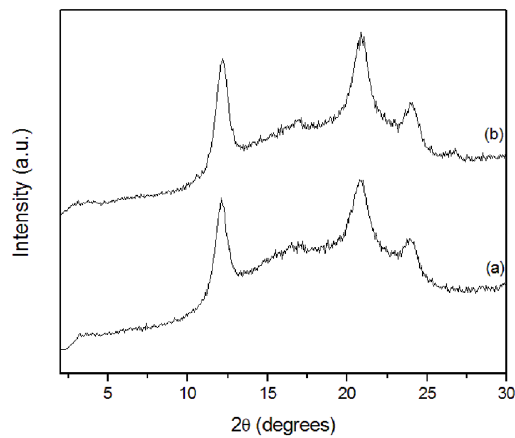
Figure 1. XRD patterns of (a) scPLA and (b) scPLA/GNPO+ nanocomposite.